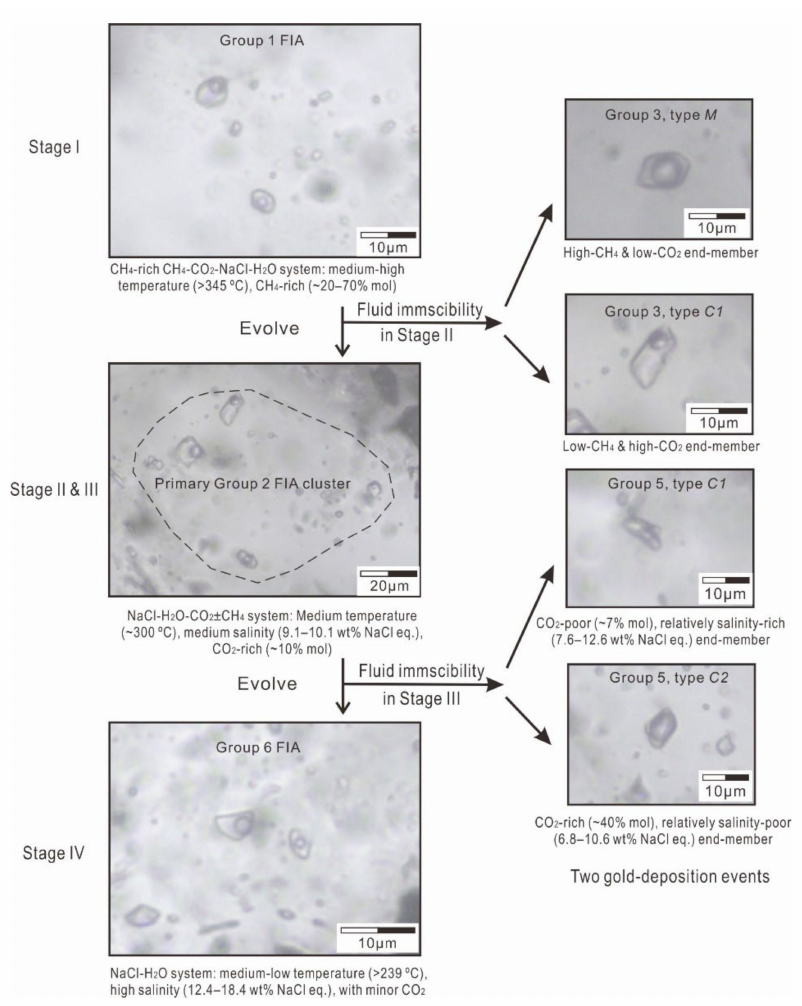
Figure 11. Evolution of ore-forming fluids and related gold-deposition processes in the Sanakham gold